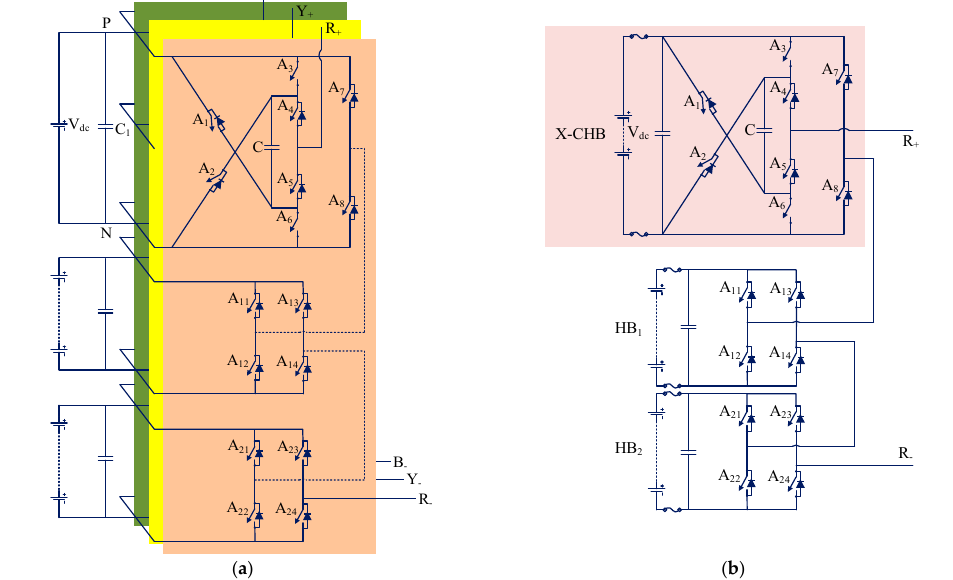
Figure 46. ( a ) Three-phase seven-level FT MLI (TP50) [82]. ( b ) Single-phase seven-level FT MLI (TP51) [82].